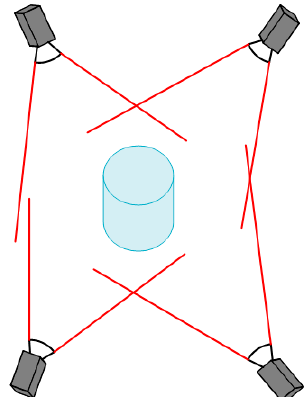
Figure 2. Multi-camera system with an overlapping FOV.